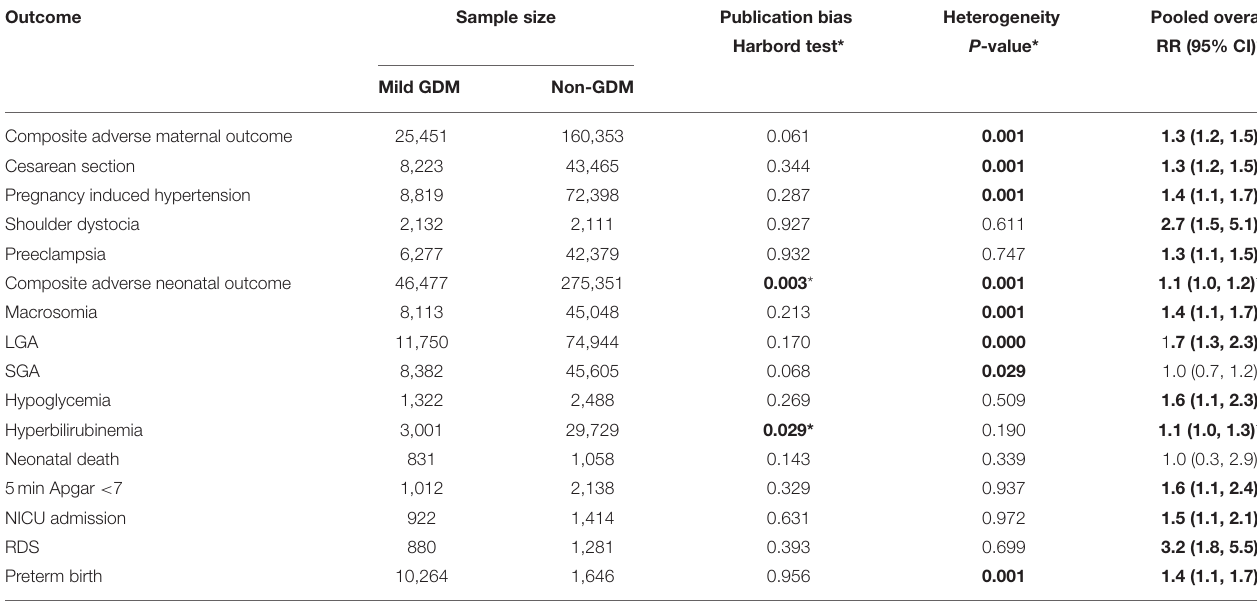
TABLE 2 | Heterogeneity, estimation of publication bias, and meta-analysis for comparing the relative risk of adverse maternal and neonatal outcomes. Outcome Sample size